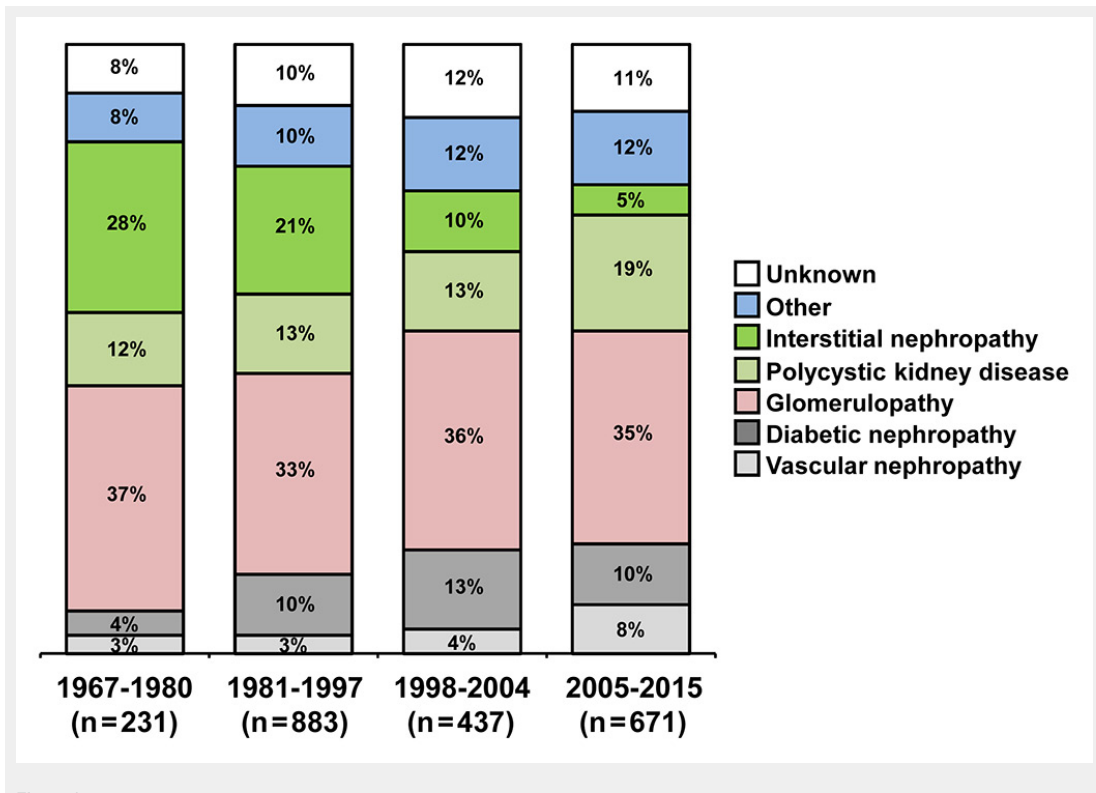
Figure 3 Evolution of underlying diseases of recipients, subdivided according to the predefined